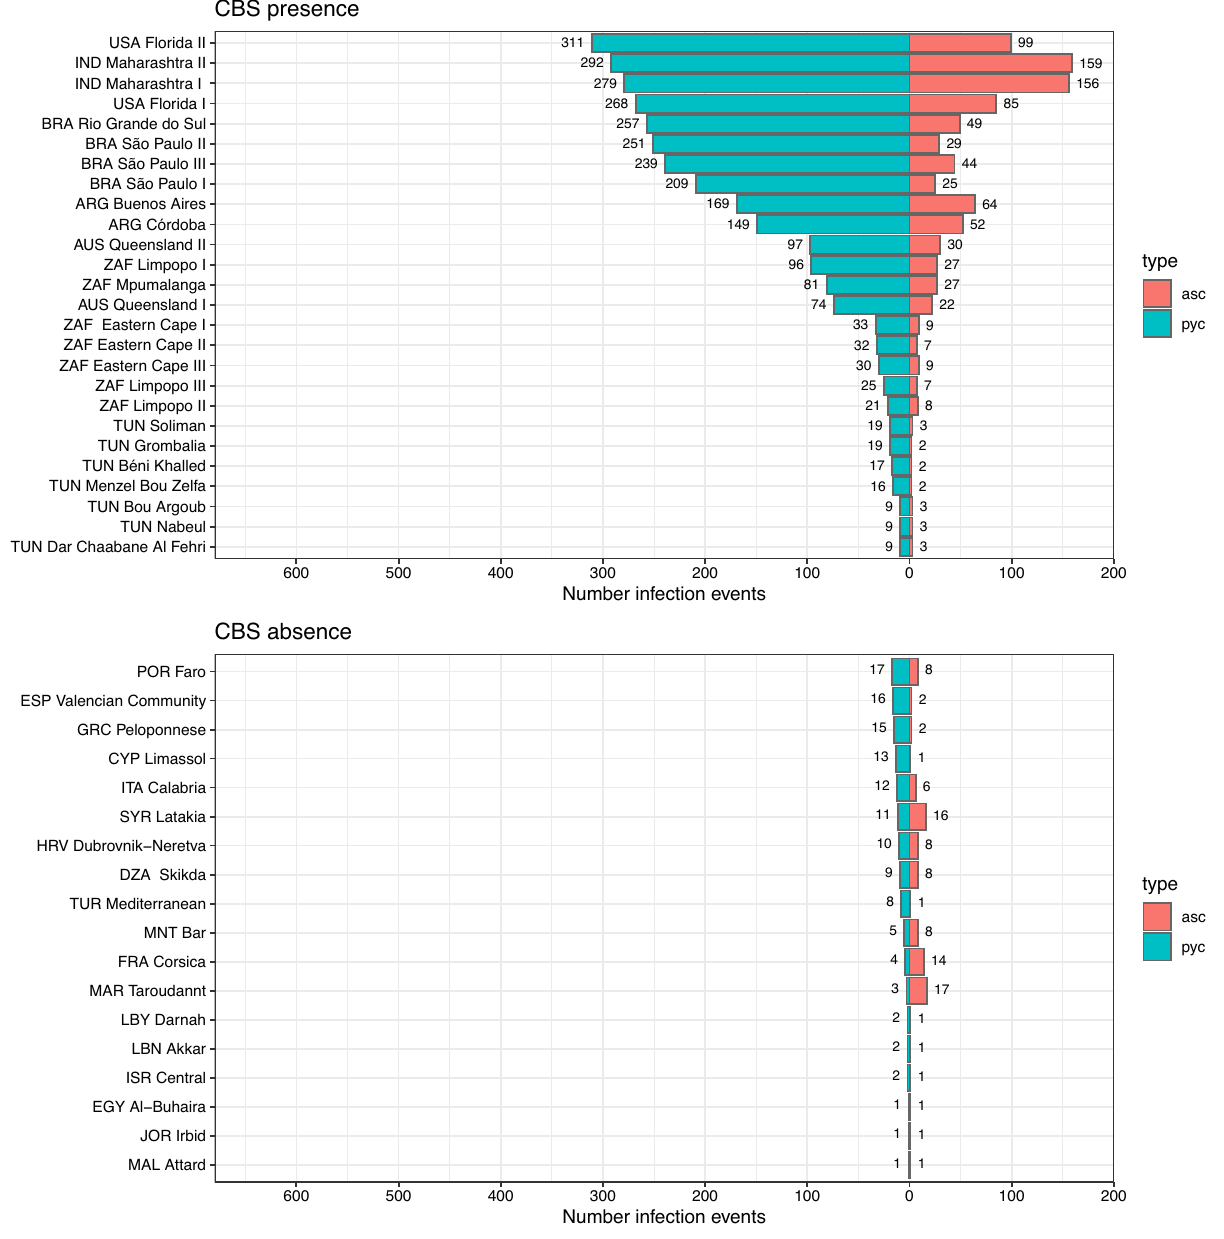
Figure 3. Number of infection events for Phyllosticta citricarpa ascospores (asc) and pycnidiospores (pyc) from 2009 to 2018 simulated by the generic infection model for foliar fungal pathogens by Magarey et al. 33 (configuration scenario S1) for locations where citrus black spot (CBS) is either present or absent. Number of infection events in x-axis and selected locations where CBS is either present or absent in y-axis. Ascospores (asc) in red and pycnidiospores (pyc) in